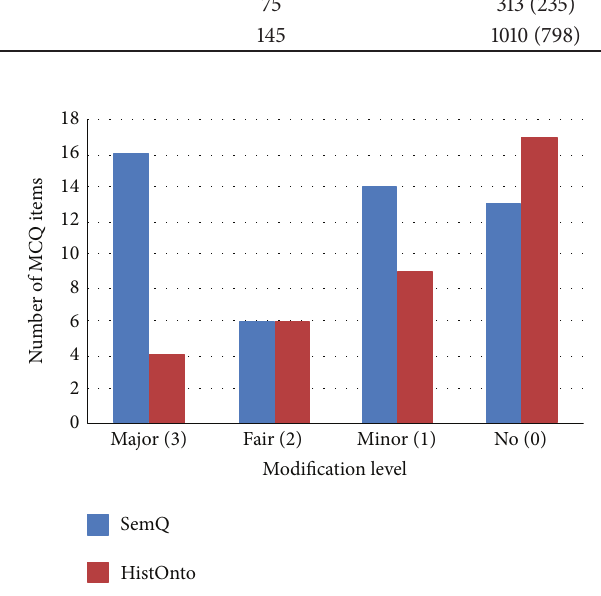
Table 5: Results of the MCQ generation task.